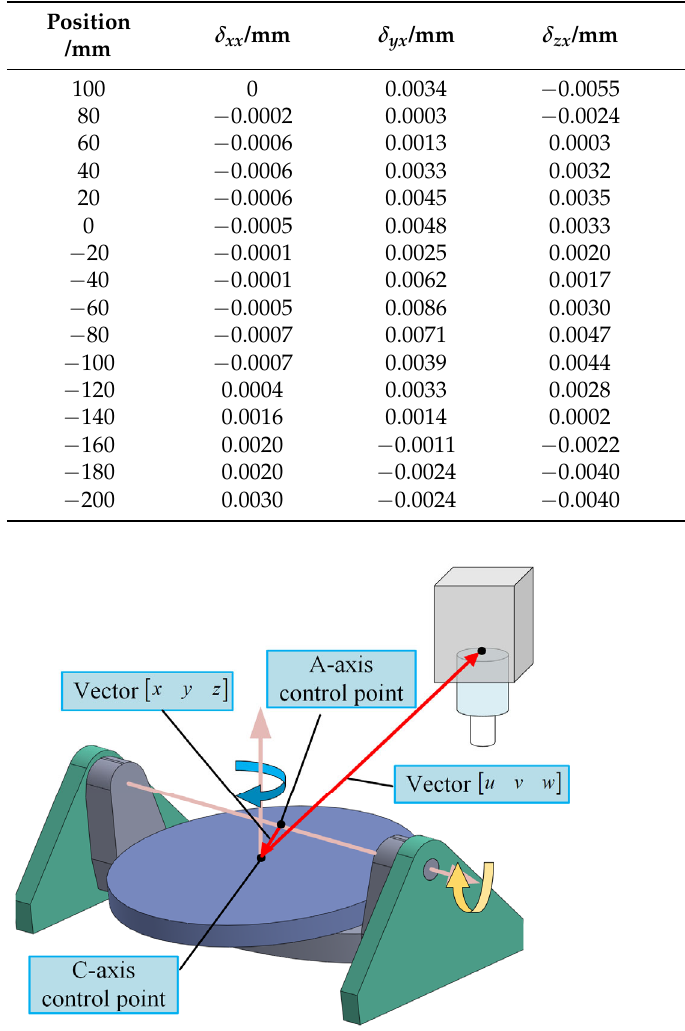
Figure 9. The relative position of control points between A ‐ axis and C ‐ axis. The kinematic chain of the KMC400S U five ‐ axis machine tool is shown in Figure 8. Set the origin of the BCS at the C ‐ axis control point. One side of the workpiece chain successively includes A ‐ axis, C ‐ axis and workpiece, and one side of the tool chain suc ‐ cessively includes Y ‐ axis, X ‐ axis, Z ‐ axis and tool. Then, the ST model of the machine tool is obtained from Equations (5)–(8) as: